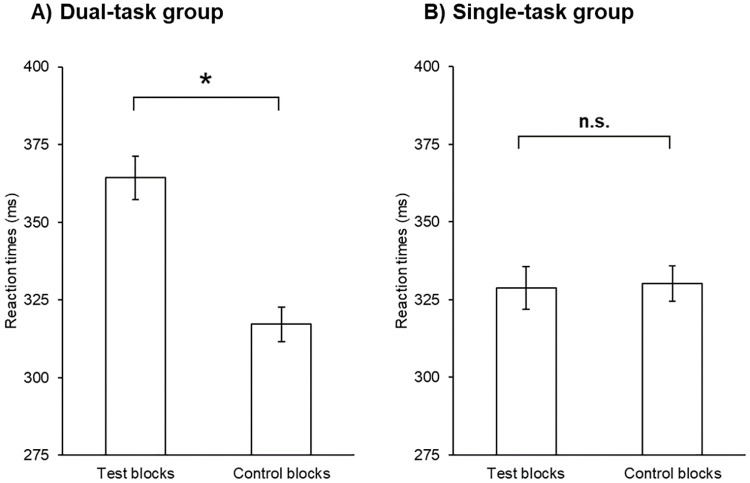
Overall RTs between the test and control blocks in (A) the dual-task group and (B) single-task group.The horizontal axis represents the two types of blocks, and the vertical axis the average RTs. The error bars signal the standard error of the mean. Participants in the dual-task group were faster in the control blocks compared to the test blocks. This pattern was not confirmed in the single-task group, revealing that the dual-task affected the average RTs. n.s.: p > .05; *: p < .05.